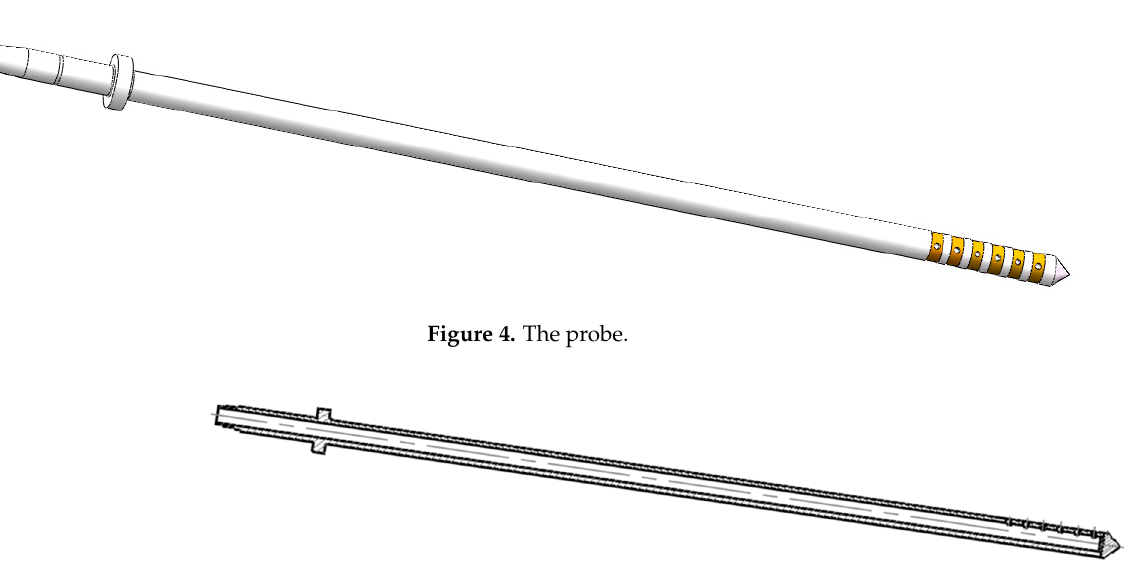
Figure 5. The probe profile diagram.